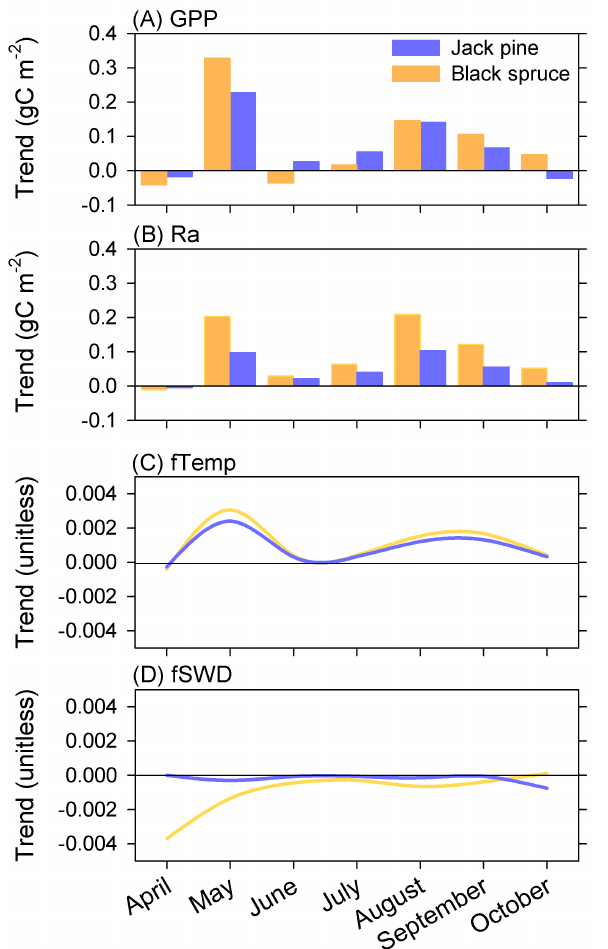
Fig. 6. Results of linear fits for detection of trends in species- averaged plot-level monthly simulations ( n = 284 plots) of (a) gross primary productivity (GPP), (b) autotrophic respiration (Ra), (c) temperature modifiers of radiation use efficiency ( f Temp ) , and (d) soil water deficit modifiers of radiation use efficiency ( f SWD ) . Pos- itive trends in f Temp and f SWD indicate that growth conditions are improving towards optimum; negative trends indicate increas- ing limitations.